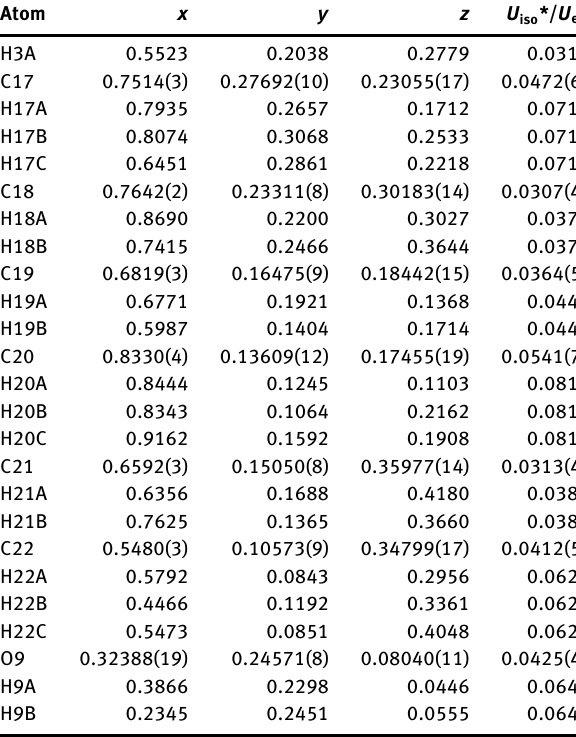
Table 2: Fractional atomic coordinates and isotropic or equivalent isotropic displacement parameters (Å 2